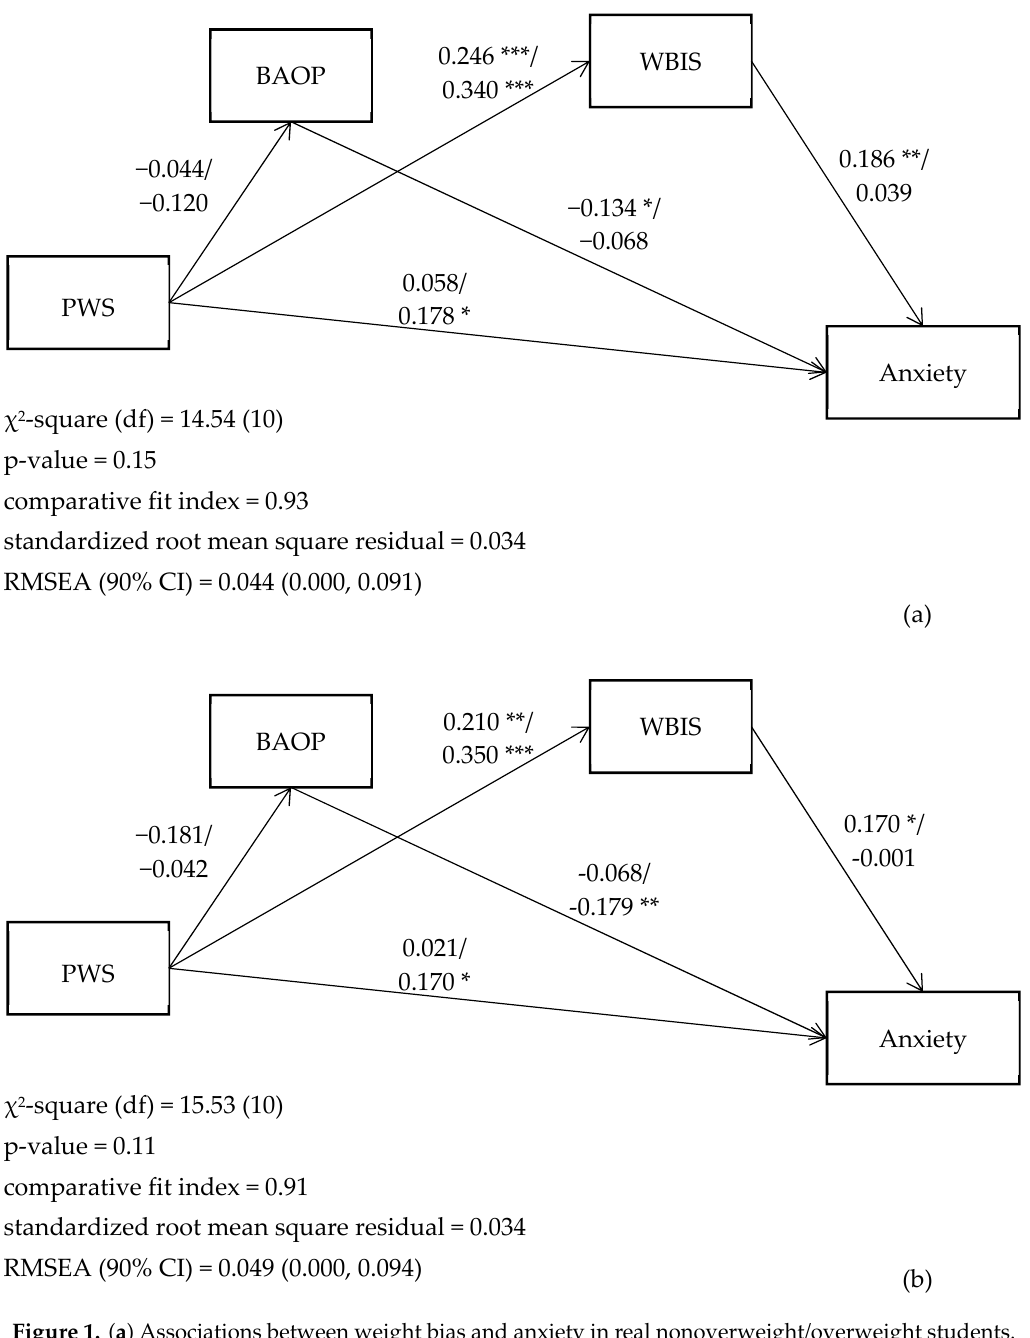
Figure 1. ( a ) Associations between weight bias and anxiety in real nonoverweight / overweight students. ( b ) Associations between weight bias and depression in self-perceived nonoverweight / overweight students. BAOP = belief about obese persons; PWS = perceived weight stigma; WBIS = weight bias internalized scale; RMSEA = root mean square error of approximation. The models are adjusted for age and gender. * p < 0.05; ** p < 0.01; *** p < 0.001.